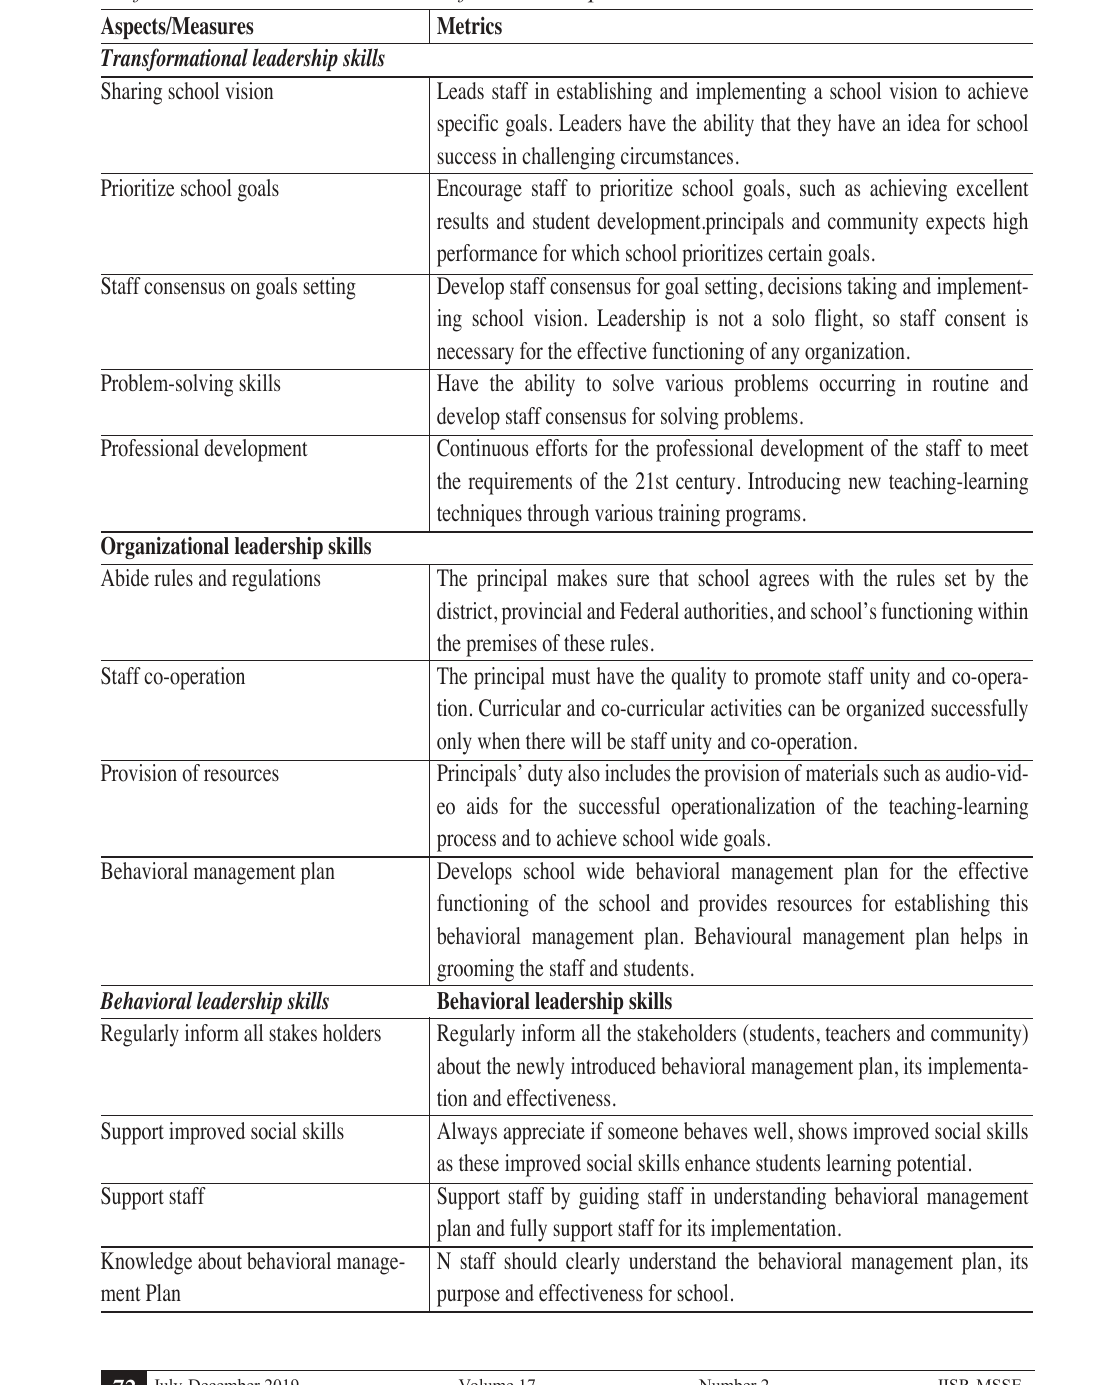
Table 1: Performance measures and metrics for leadership skills assessment